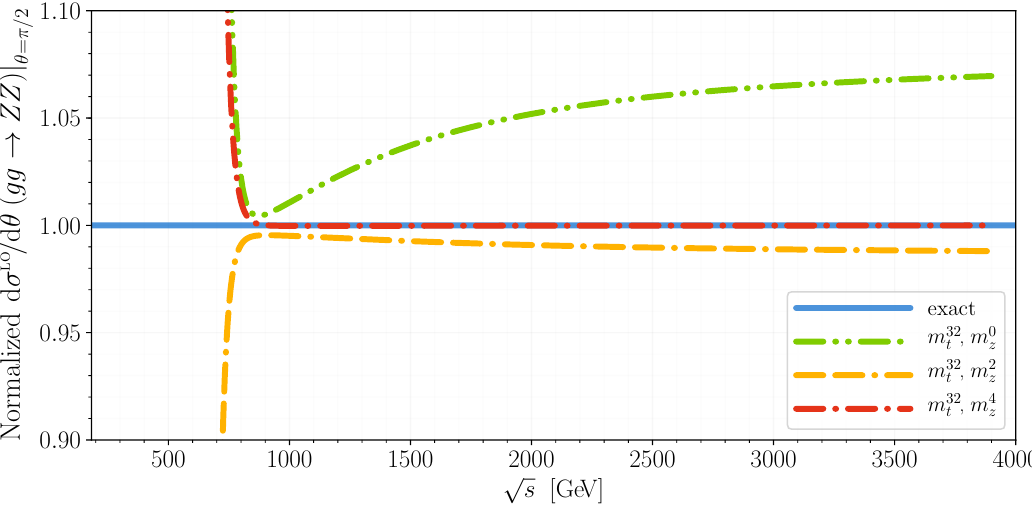
Figure 4 . LO partonic di(cid:11)erential cross section for gg result. The three high-energy expansions contain terms up to order m 32